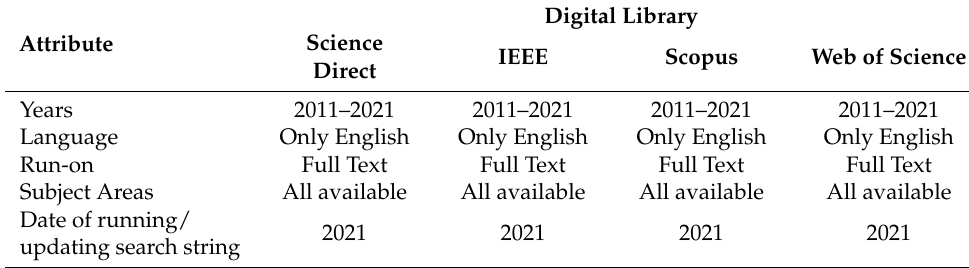
Table 1. Workflow procedure.